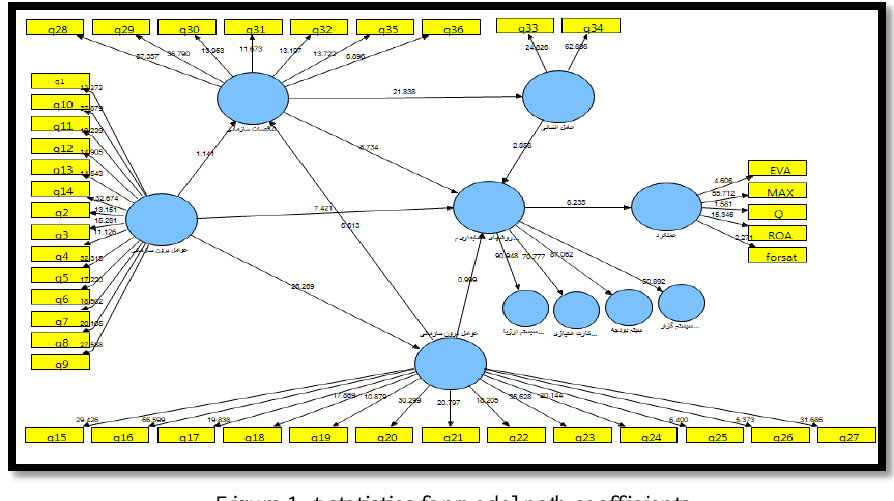
Figure 1. t-statistics for model path